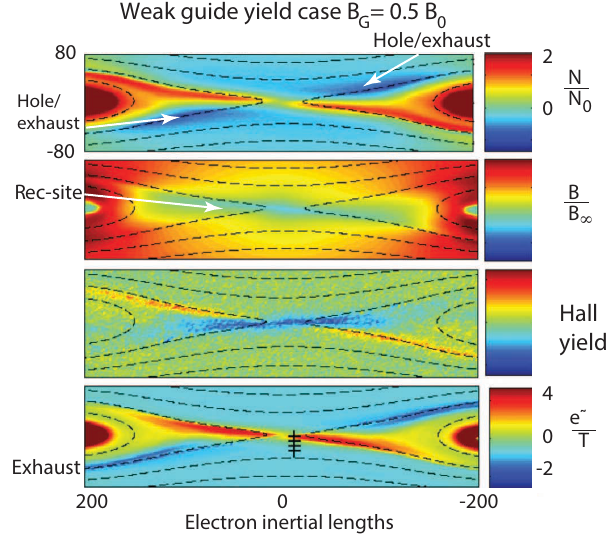
Figure 2. Weak guide ( B g = 0 . 5 B 0 ) field PIC simulations of col- lisionless spontaneous reconnection in 2-D (after Le et al., 2010) with current and guide field perpendicular to the plane. From top to bottom: normalized density, normalized magnetic field, Hall field structure, electric reconnection potential. The density exhibits the asymmetric exhaust (deep blue) and (red) electron accumulation re- gions caused by the E × B g drift in the reconnection electric and guide fields. The nearly rectangular box reconnection region cen- tred at the X point is characterized by a weak magnetic field. Very weak Hall fields arise due to the immobile ion background which for our purposes are of no interest. They just contribute to asymme- try. The electric potential shows region of different signs equivalent to the density structure. Note that in this writing positive potentials attract, negative potentials expel electrons. Note the very long hori- zontal extension of the reconnection site which reaches a length of roughly L ∼ 300 λ e which means ± 150 λ e to both sides in spite of the fact that the electrons in the guide field remain partially magne- tized. The ion inertial length λ i ≈ 43 λ e implies that the reconnec- tion site is elongated on each side by up to (cid:38) 3 λ i . The magnetization of the electrons in the guide field perpendicular to the reconnection field affects the reconnection process only very